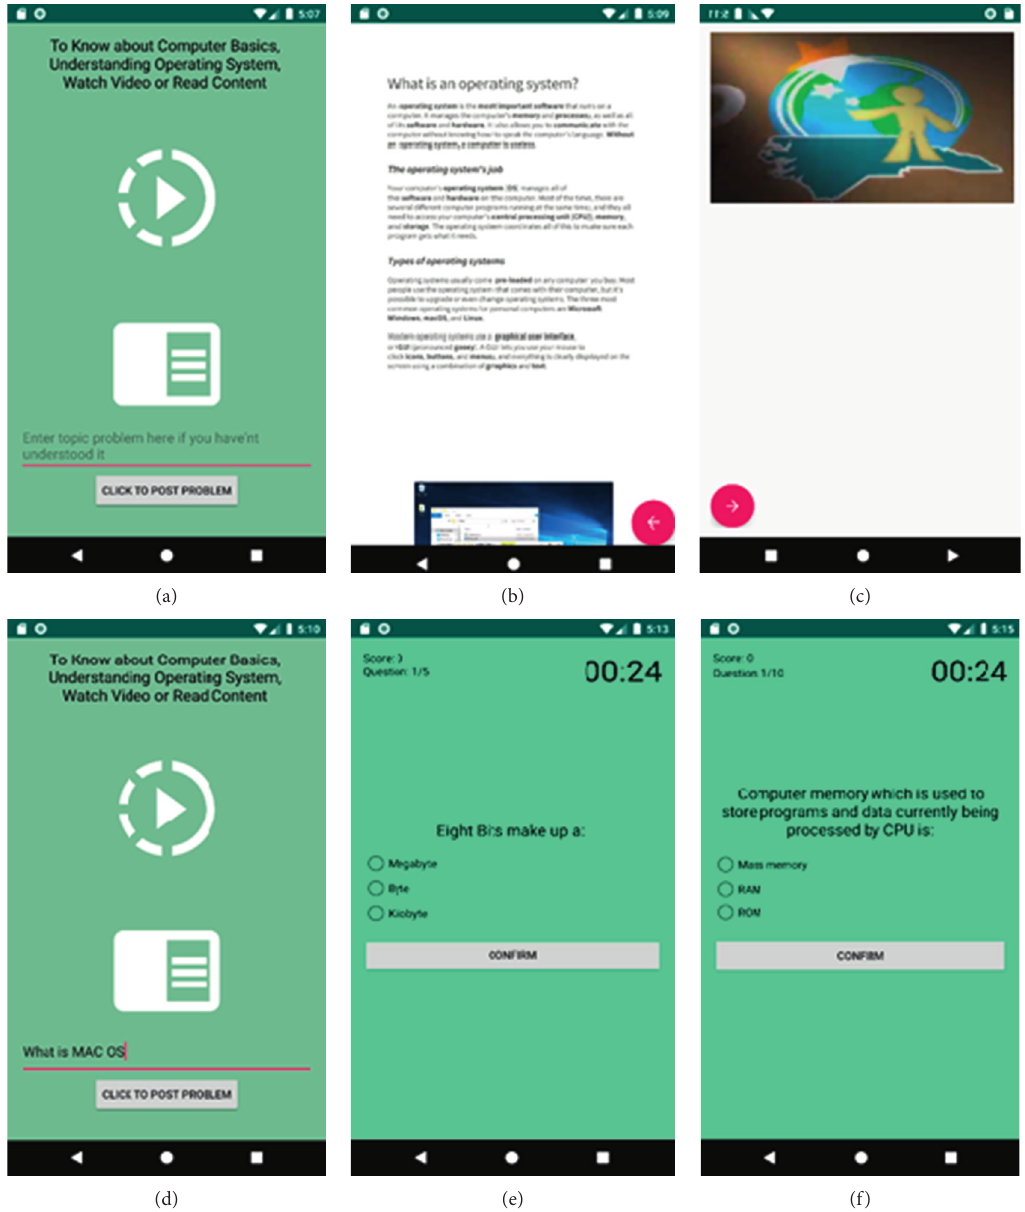
Figure 3: Learner learning, problem posting, and quiz activities. (a) Video or text selection activity. (b) Learner reading text content. (c) Learner watching video content. (d) Problem posting related to a particular topic. (e) Module quiz activity. (f) Final quiz